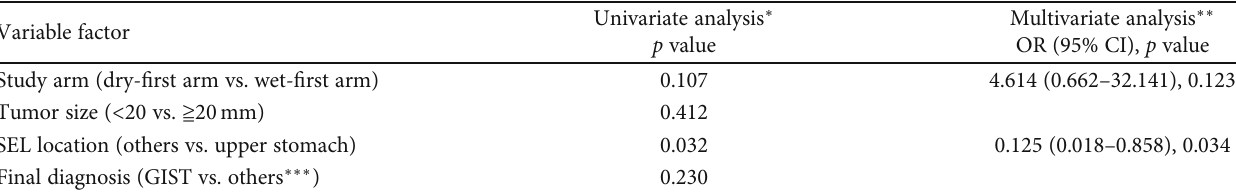
EUS-FNA: endoscopic ultrasound-guided fi ne-needle aspiration; SEL: subepithelial lesion; GIST: gastrointestinal stromal tumor; DRY: dry technique; WET: wet technique; OR: odds ratio; CI: con fi dence interval. ∗ Chi-squared test or Fisher ’ s exact test. ∗∗ Multivariate logistic regression analysis (acellular and poor cellularity; cellularity scores of 0 and 1 vs. moderate and high cellularity; scores of 2 and 3). ∗∗∗ Including cases which were not diagnosed by